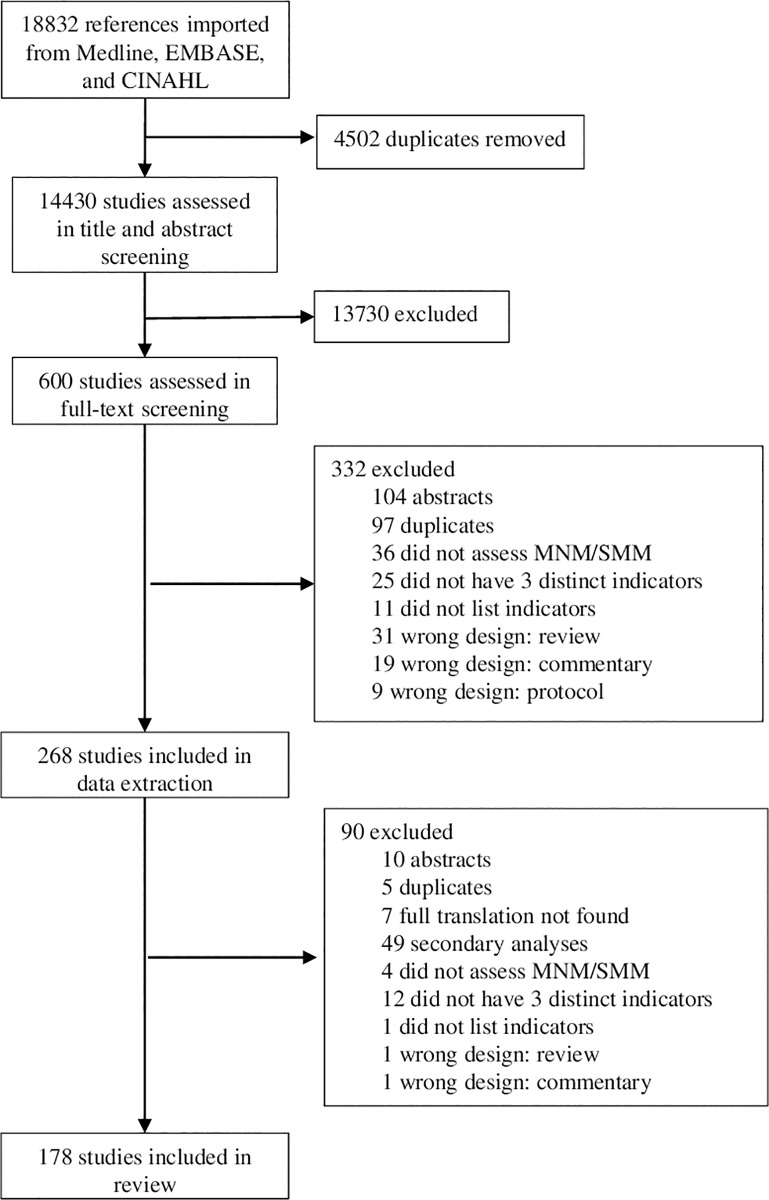
PRISMA flow diagram for systematic review of global monitoring practices for maternal near miss/severe maternal morbidity.